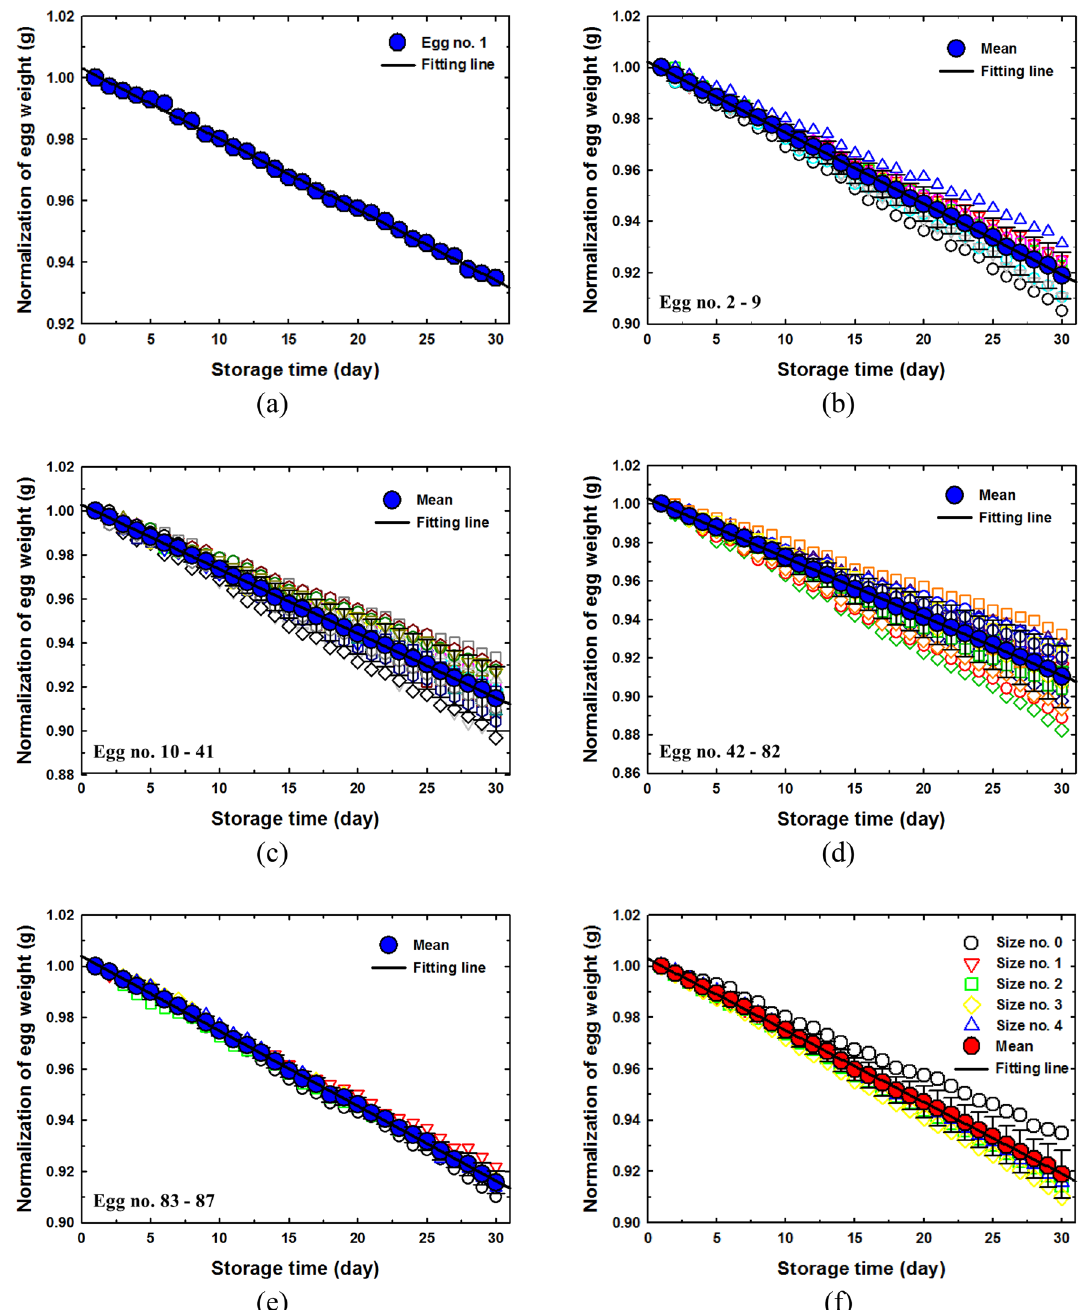
Figure 7. Weight as function on storage time ( a ) size classification number 0, ( b ) size classification number 1, ( c ) size classification number 2 ( d ) size classification number 3, ( e ) size classification number 4 and ( f ) all size classification